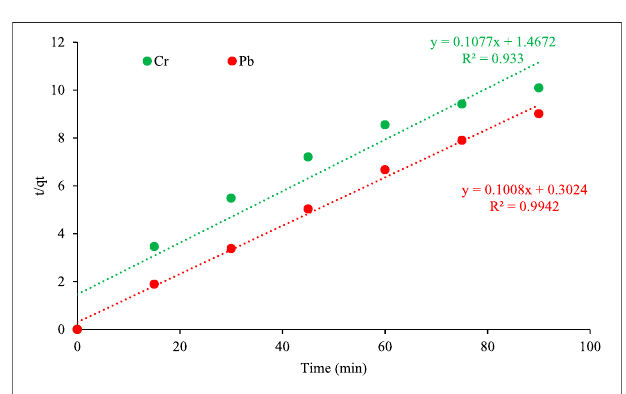
FIGURE 10 | Pseudo second order kinetic plot of metal adsorption on orange peel/selenium nanocomposite.